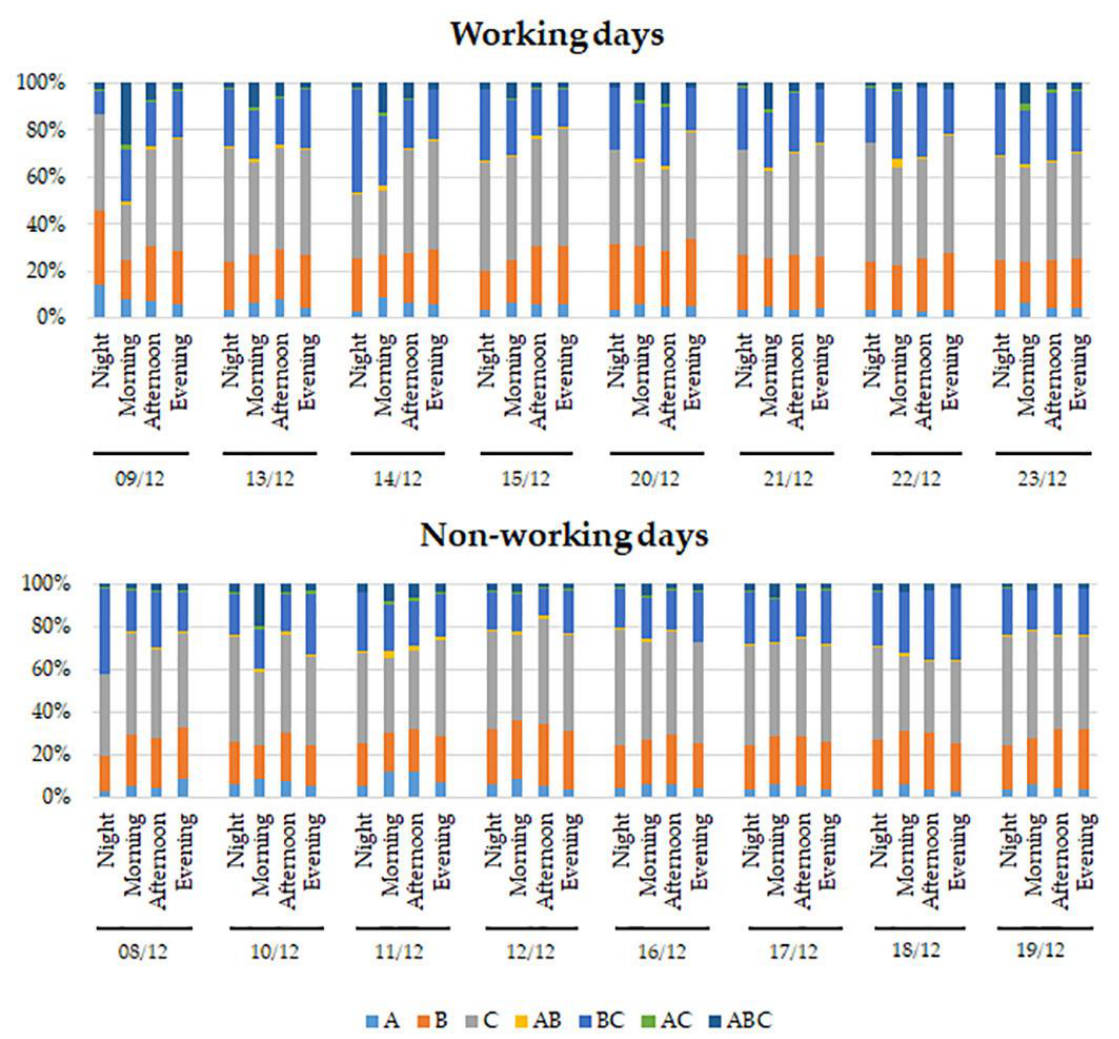
Figure 6. Daily percentage of fluorescent particles belonging to different channels ( y -axis), divided into four 6-h ranges ( x -axis). Working days (WDs) and non-working days (NWDs) are shown separately.